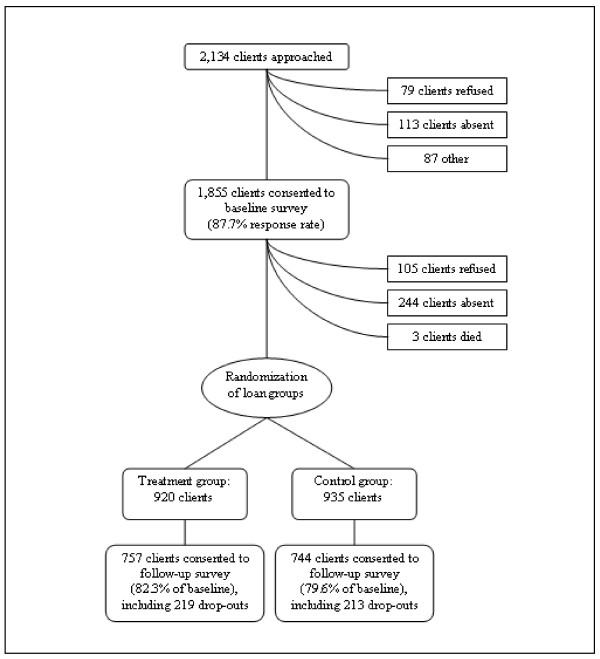
Sampling framework.